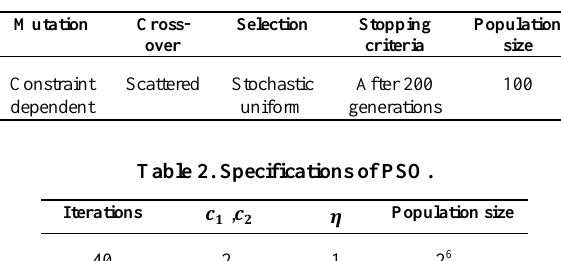
Table 1. Specifications of GA.